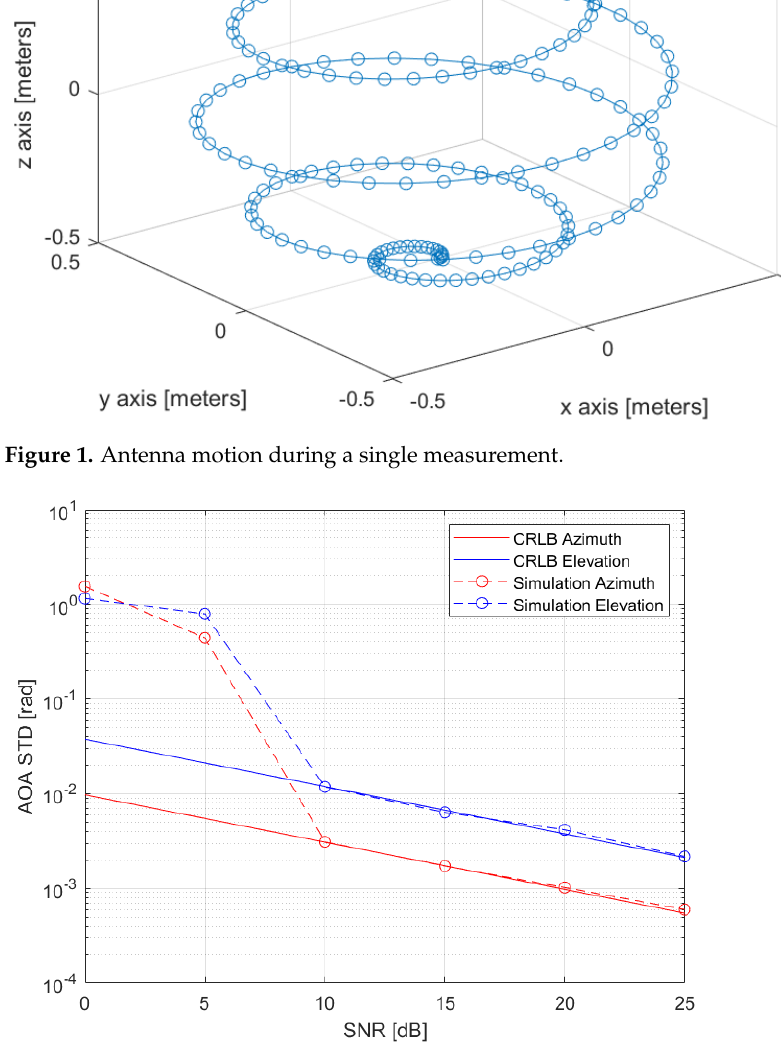
Figure 2. AOA standard deviation vs. SNR. Elevation is shown in blue, azimuth in red, CRLB in solid lines, and simulations in dashed lines with the circle marker.